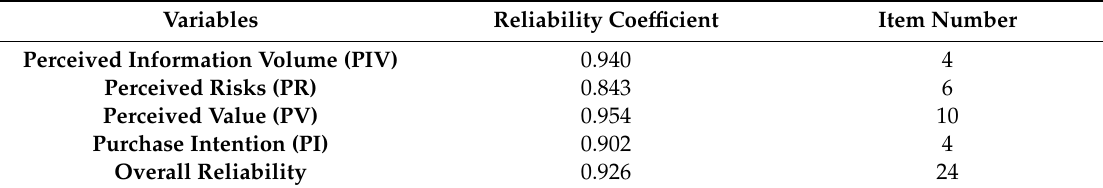
Table 4. Reliability analysis of variables.